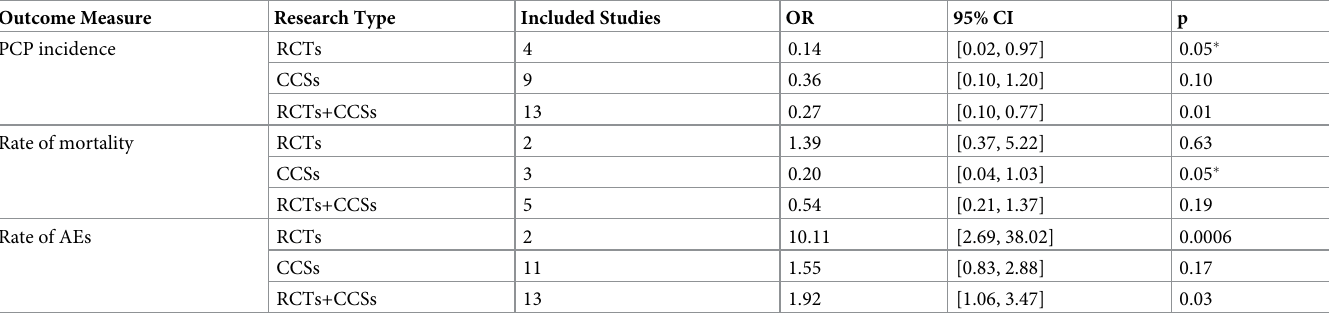
Table 2. Summary of the meta-analysis of each outcome measure stratified by study